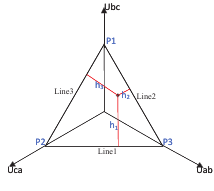
Figure 4. Triangle of class A.